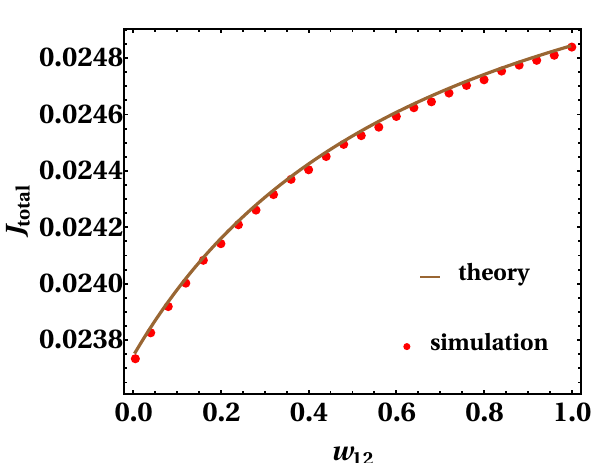
Figure 13: The figure shows the variation of the total drift current of species 1 and 2 with the flip rate w . While the flip rate (equiva- 12 lent lane change rate in two lane TASEP) is varied over a large range ∈ ( 0,1 ) , the corresponding increase in the total drift current (total flow w 12 along the two lanes in TASEP) is reasonably small. The parameters used are = 0.3, p = 1.0, ε = 0.1, w = 1.0, ρ = 0.2, ρ = 0.2. The L = 10 4 , p + 1 2 21 0 ensemble average is done over 10 7 samples.